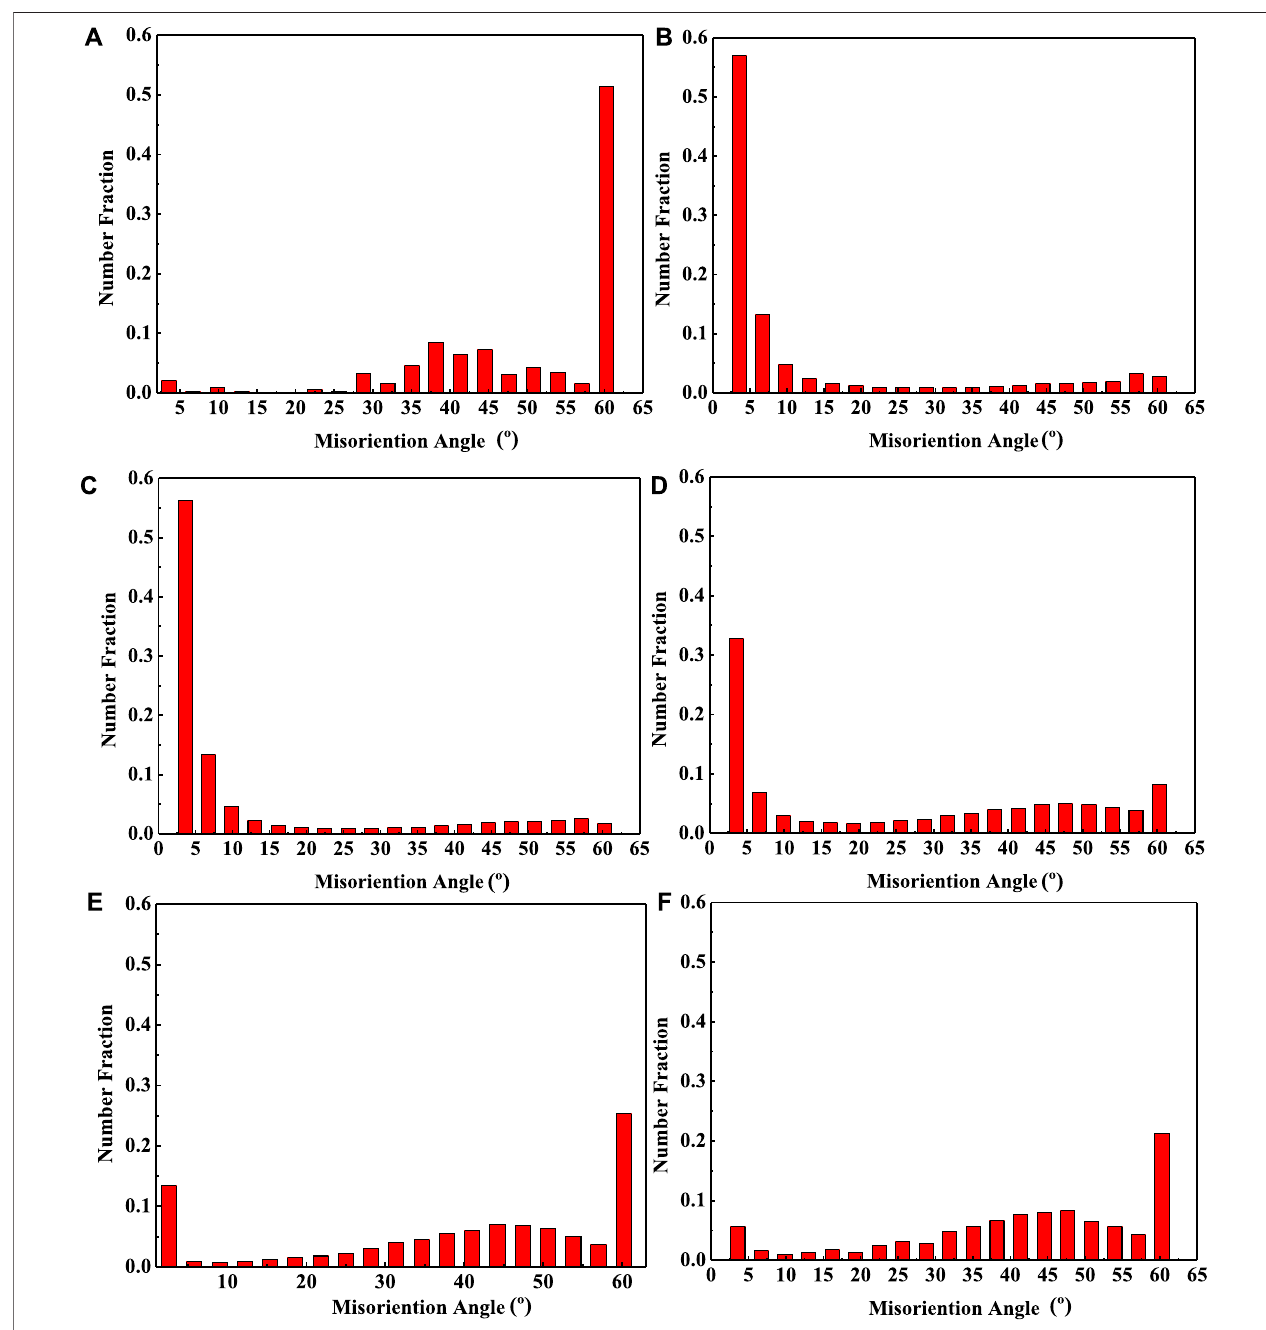
FIGURE 4 | Misorientation distribution histogram at different temperatures with the strain rate of 0.1 s − 1 : (A) solution, (B) 1,000 ° C, (C) 1,050 ° C, (D) 1,100 ° C, (E) 1,150 ° C, and (F) 1,200 ° C.